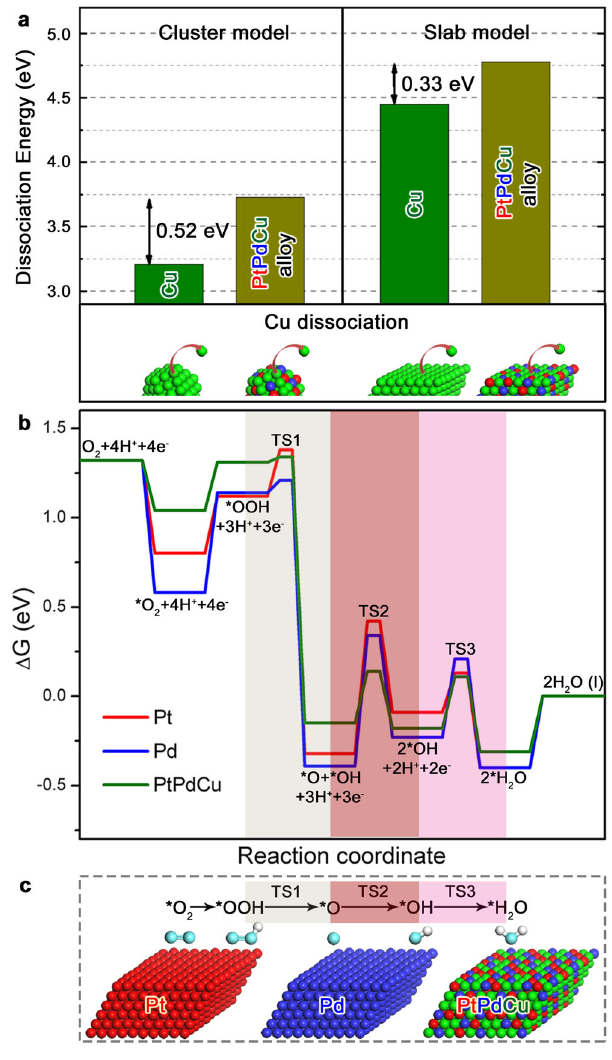
Fig. 5 Theoretical modeling of enhanced stability and activity of the ternary alloy catalyst. a A comparison of the calculated dissociation energies of Cu atom from pure Cu and PtPdCu alloy based on cluster and slab models. b A free energy ( Δ G ) diagram comparing the energetics for the different ORR species and the reaction barriers for some key elementary steps in ORR on Pt (111), Pd (111), and PtPdCu (111) surface models at 0.9 V with respect to Computational Hydrogen Electrode (CHE). “ TS1 – TS3 ” represents the transition states for the three elementary steps, as indicated. c Illustration of the ORR mechanism based on the corresponding models of Pt (111), Pd (111), and PtPdCu (111) surfaces for the calculation. Red, dark-blue, green, light-blue, and white balls represent Pt, Pd, Cu, O, and H atoms,